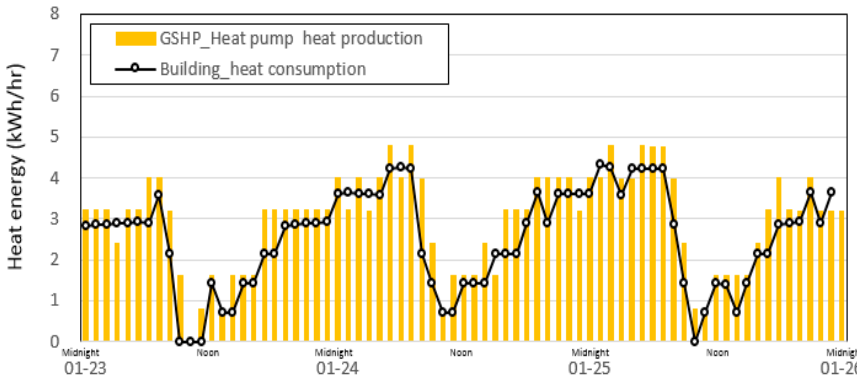
Figure 17. The heat production of the GSHP system during the representing 3-day period. Energies 2017 , 10 , 1243